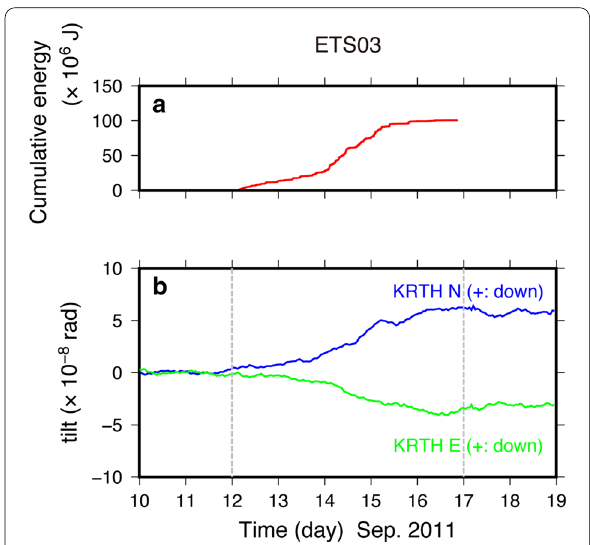
Fig. 4 Plots showing ( a ) the evolution of energy release in ETS 3 and ( b ) detided and detrended tiltmeter records during ETS 3 at Hi-net tiltmeter station KRTH (Hirose and Kimura 2012); location shown in Fig. 1c. Lines labeled KRTH N (blue) and KRTH E (green) denote tilt components down to the north and east, respectively. Vertical dashed lines in ( b ) mark the start and end of the ETS episode estimated from tiltmeter records (Hirose and Kimura 2012) (Table